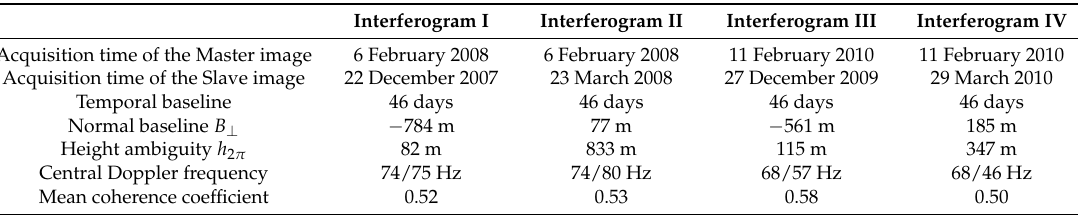
Table 6. Parameters for ALOS/PALSAR interferometric pairs.